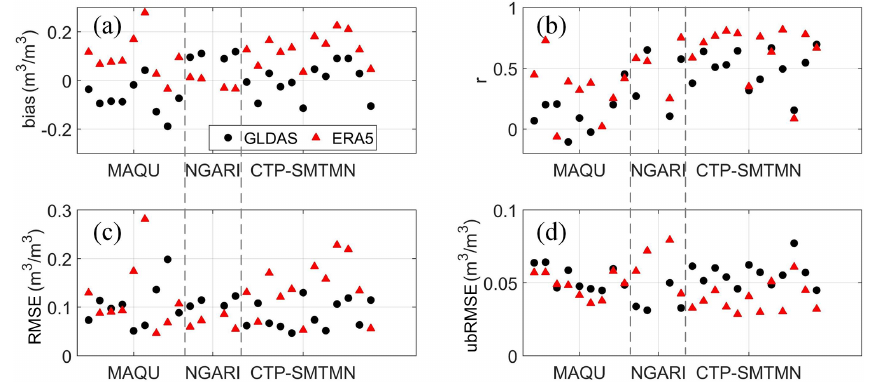
Figure 3. The (a) bias, (b) Pearson correlation coefficient ( r ), (c) root mean square error (RMSE), and (d) unbiased RMSE (ubRMSE) for GLDAS and ERA5 soil moisture in the summer period of May–September over 2008–2014 based on the ISMN station measurements from the MAQU, NGARI, and CTP-SMTMN observation network.